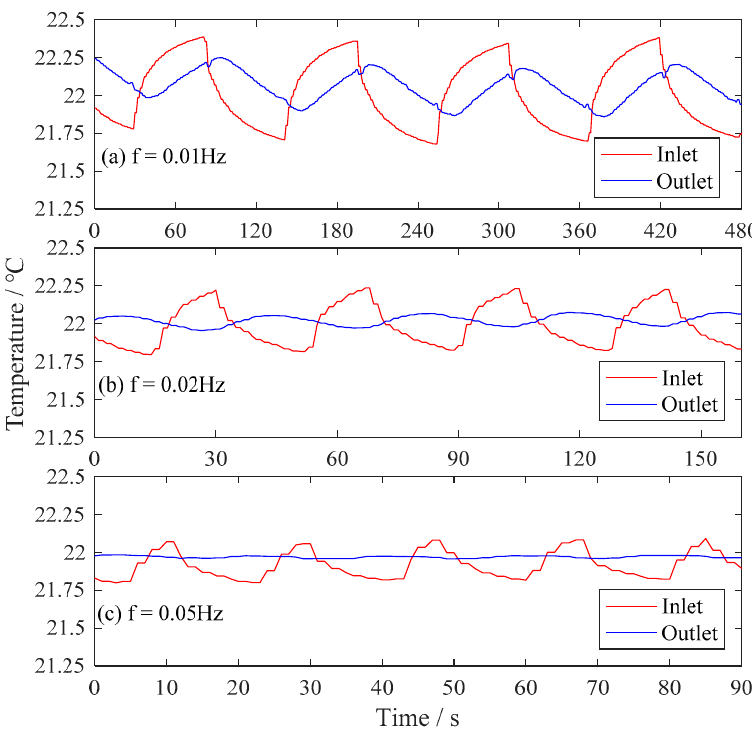
Figure 5. Modeling results of the temperature fluctuation ratio of the DTFM attenuator.